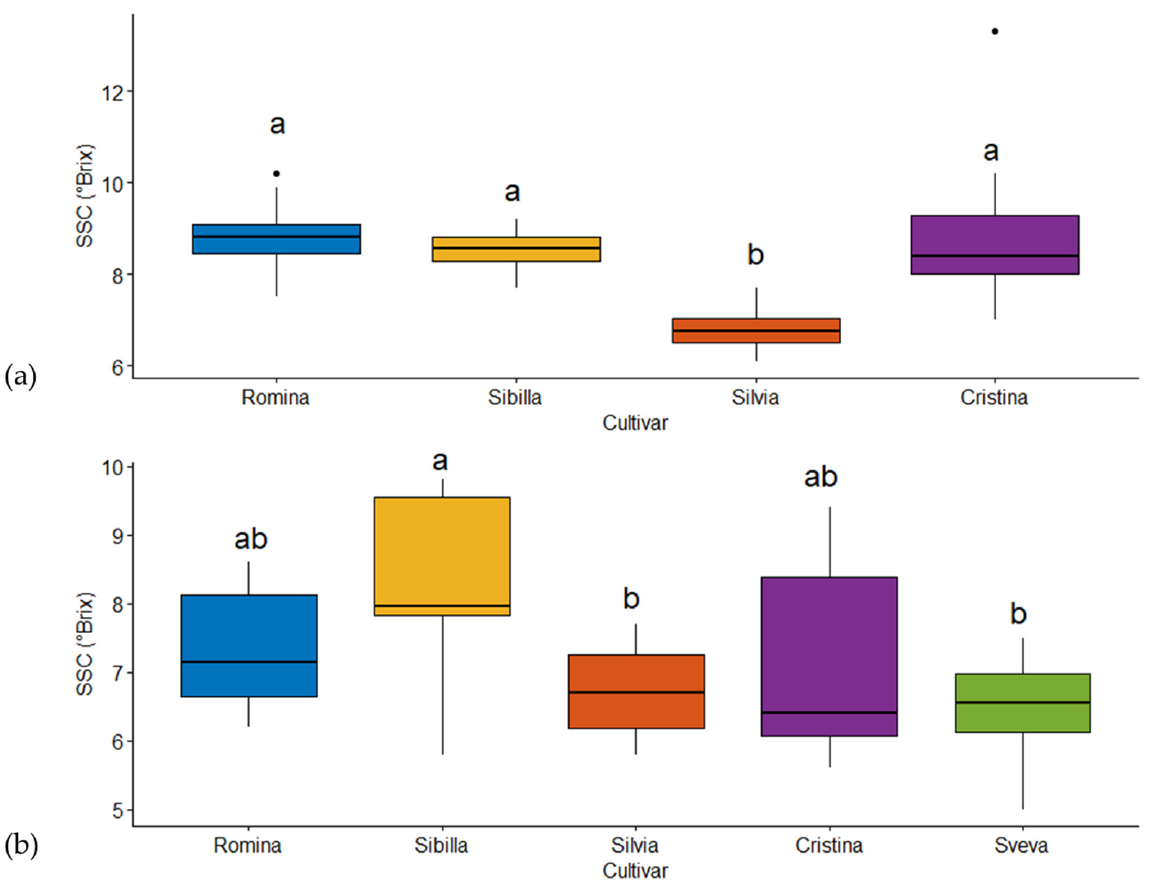
Figure 1. Results of one-way ANOVA for harvest seasons 2020 ( a ) and 2021 ( b ). The mean value of each cultivar is represented with the horizontal black line, the boxes cover the interquartile interval where 50% of the data is found, and they indicate the upper and lower quartiles. The whiskers indicate the maximum and minimum values of SSC content ( ◦ Brix) within each cultivar. Different lowercase letters indicate a significant difference ( p ≤ 0.05, Tukey test) between the strawberry cultivars.